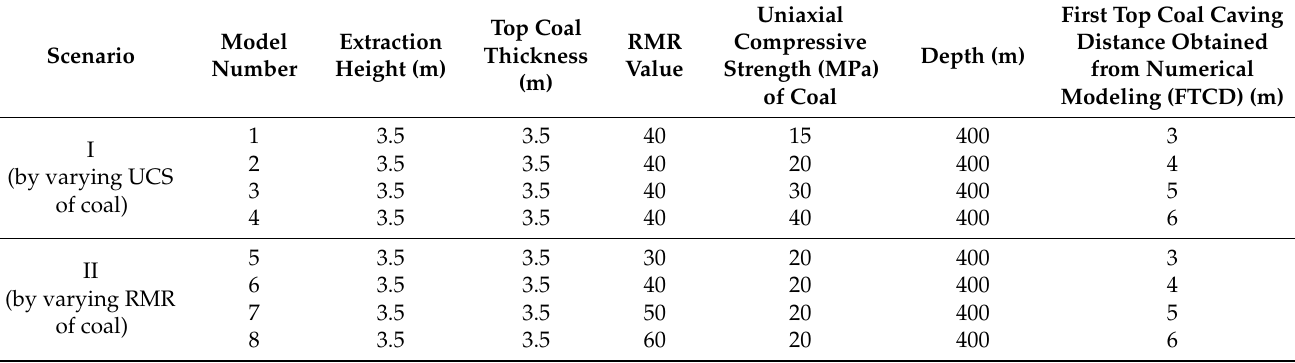
Table 3. Summary of scenarios of numerical modeling with FLAC 3D.